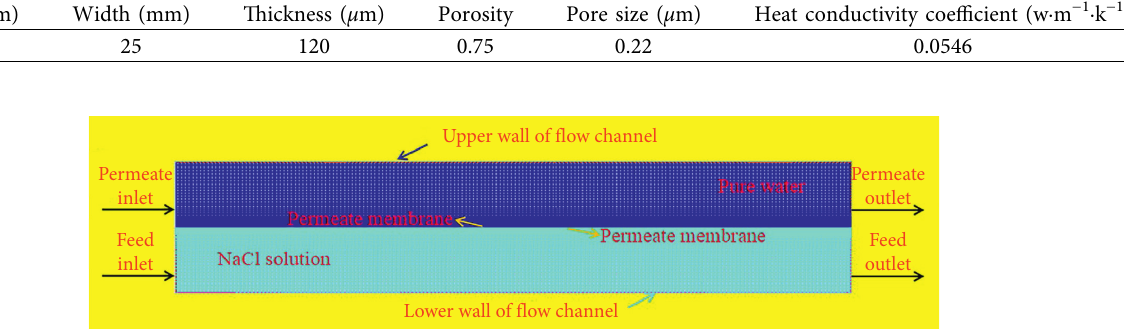
Figure 3: Schematic diagram of specific meshing results.